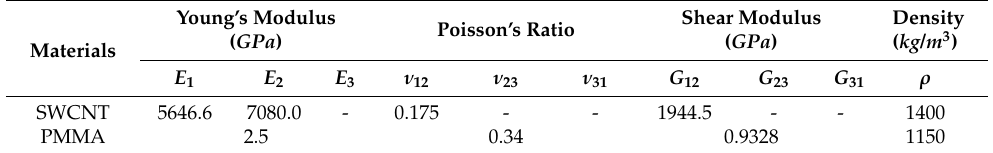
Figure 5. A simply supported FG-porous CNTRC beam: ( a ) dimensions and loading/boundary conditions, ( b ) uniform sub-layers. Table 2. Material properties of SWCNT and matrix (PMMA) [41].